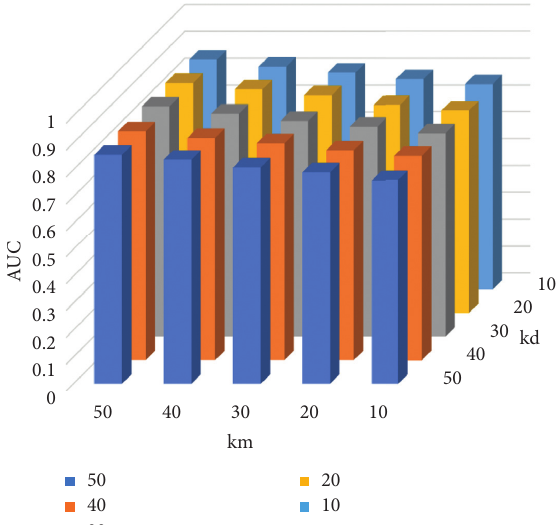
Figure 5: AUCs of different parameters under 10-fold cross validation. It shows the comparison of the parameters by integrating the data in Tables 1 and 2.